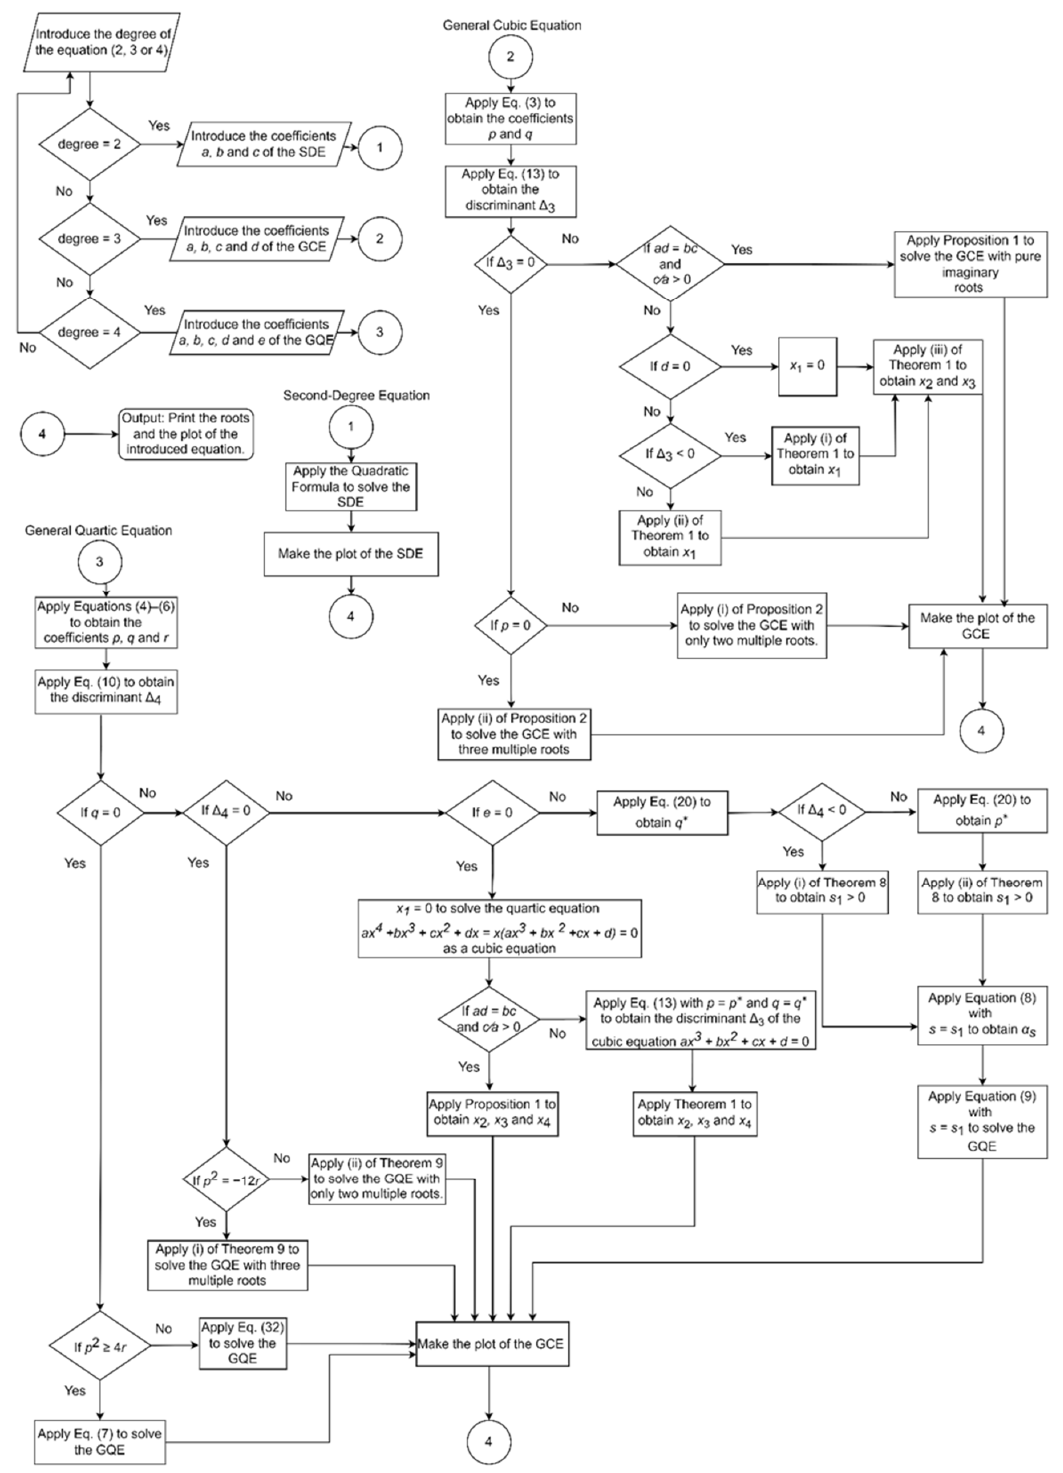
Figure 1. Flowchart of a program that analytically solves the SDE, the GCE and the GQE, without complex arithmetic.